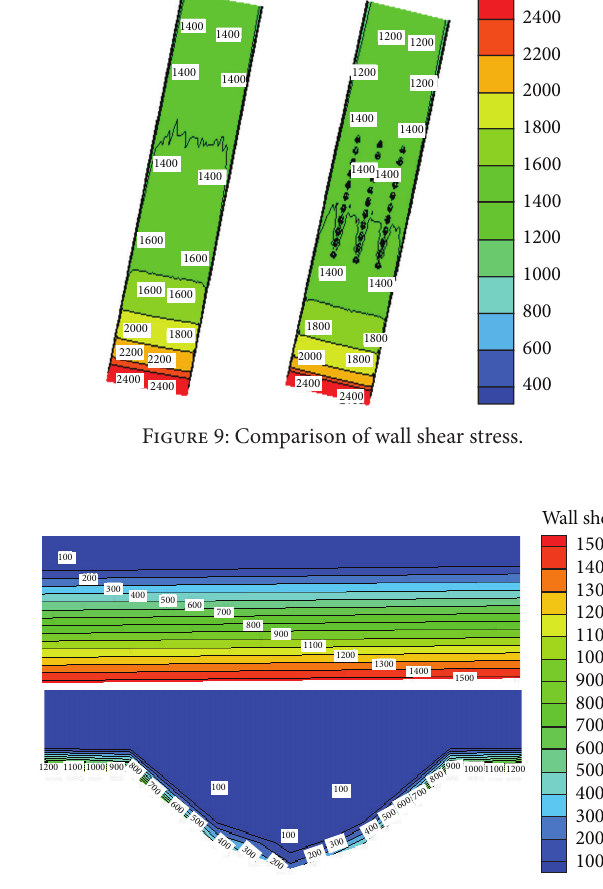
Figure 10: Comparison of shear stress at 𝑥 = 15